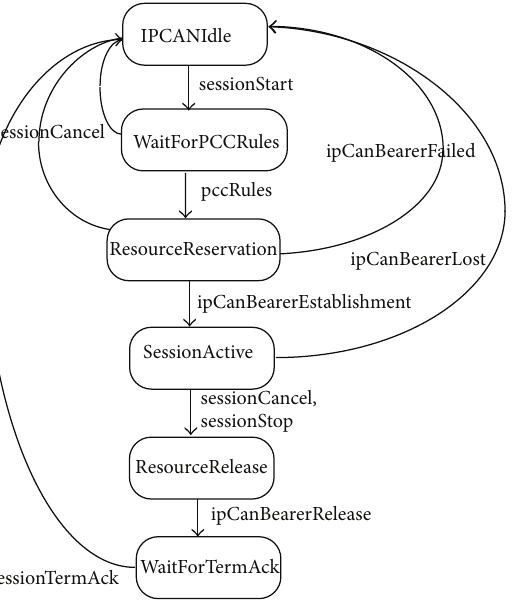
Figure 7: IP-CAN session state machine.